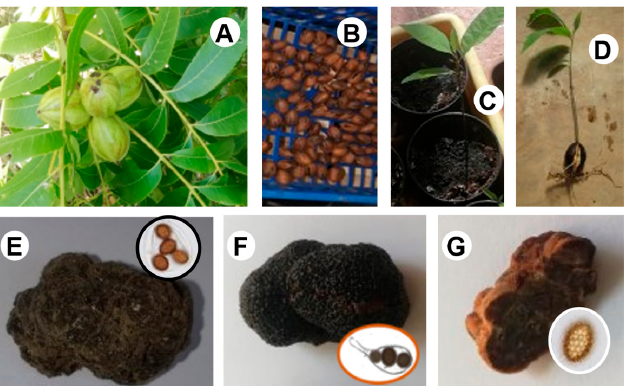
Figure 1. The material used in mycorrhization: pecan ‘Shoshoni’ drupes ( A ), seeds ( B ), seedlings in the emergency phase ( C ) and ‘Shawnee’ bare root seedling ( D ); ascomata, asci and ascospores of T. aestivum ( E ), T. melanosporum ( F ), T. borchii ( G